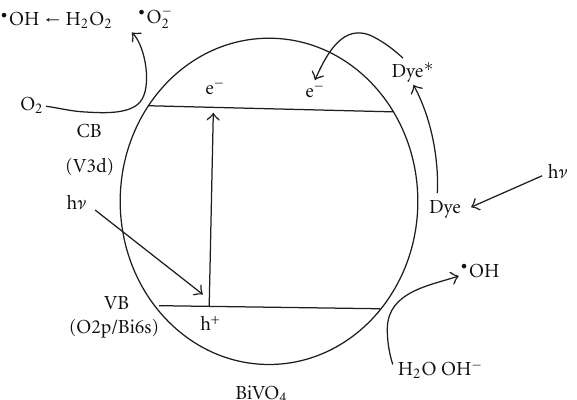
Figure 6: Photocatalytic mechanism for the mesoporous BiVO 4 nanorods over MB.